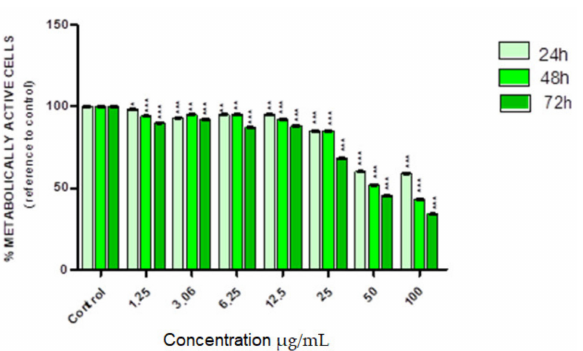
Figure 6. Viability of HepG2 cells after treatment with different concentrations of SPION@Au–PEG bioconjugate. The viability of cells was measured using MTS assay after incubation for 24, 48, and 72 h. The results are expressed as a percentage of control cells. Significant p ≤ 0.1 (*), p ≤ 0.01 (**), p ≤ 0.001